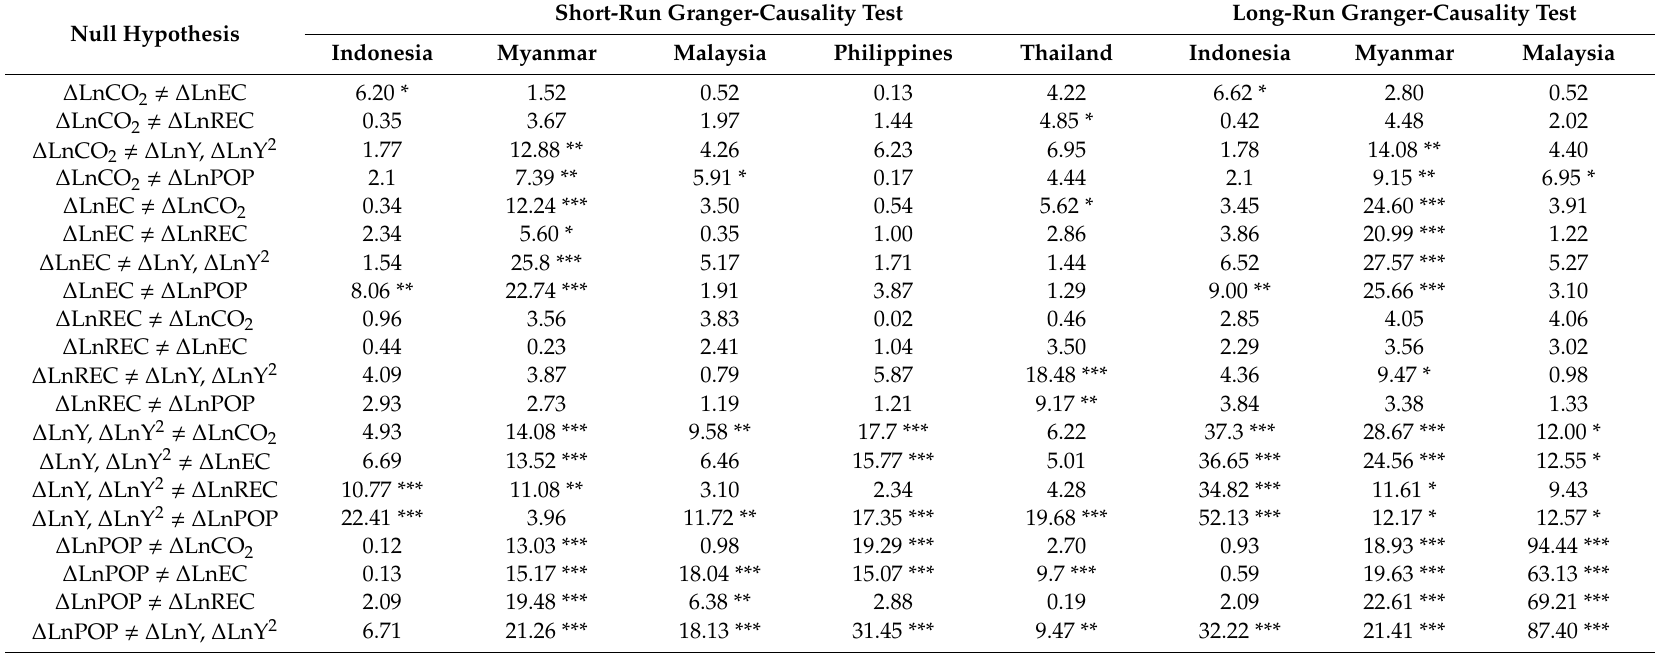
Table 5. Results of Granger-causality